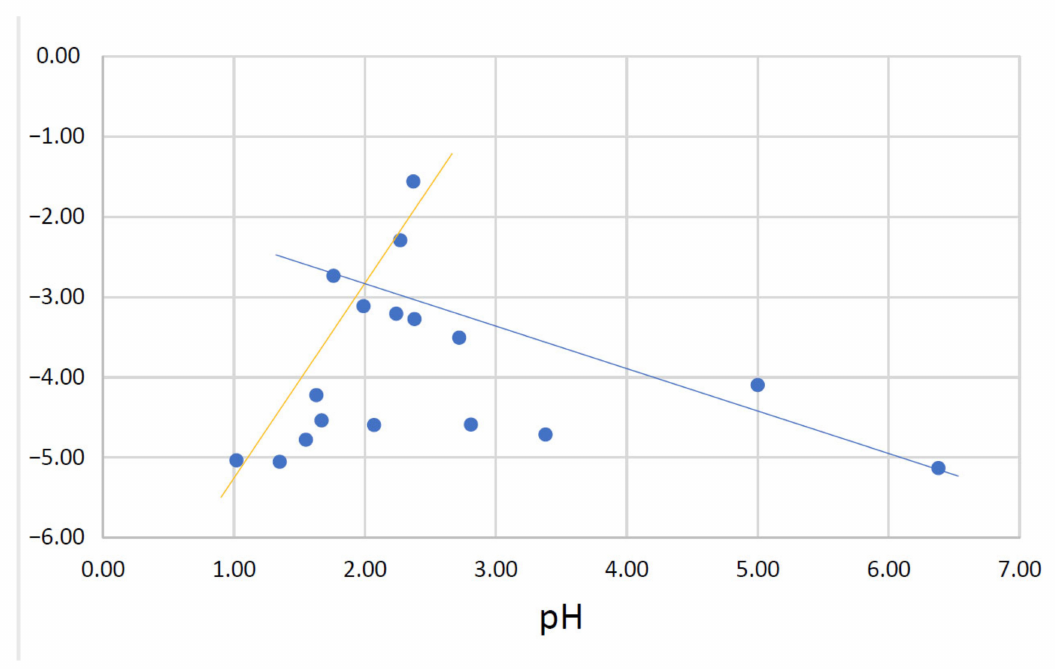
Figure 18. Scatterplot of pH and δ 18 O values from the spring solutions, resulting no correlation between them. The excessive volumes of sulfides within the Rio Tinto subsurface which interact with the groundwater have been observed to modify the 18 O signature [37]. High sulfate levels are reported to have minimal influence on the isotopic signatures as a result of minimal isotopic exchange occurring due to the rate of reaction (~350 years) [43,70,71]. Previous research has interpreted Rio Tinto to be consistent with a sulfite-water system